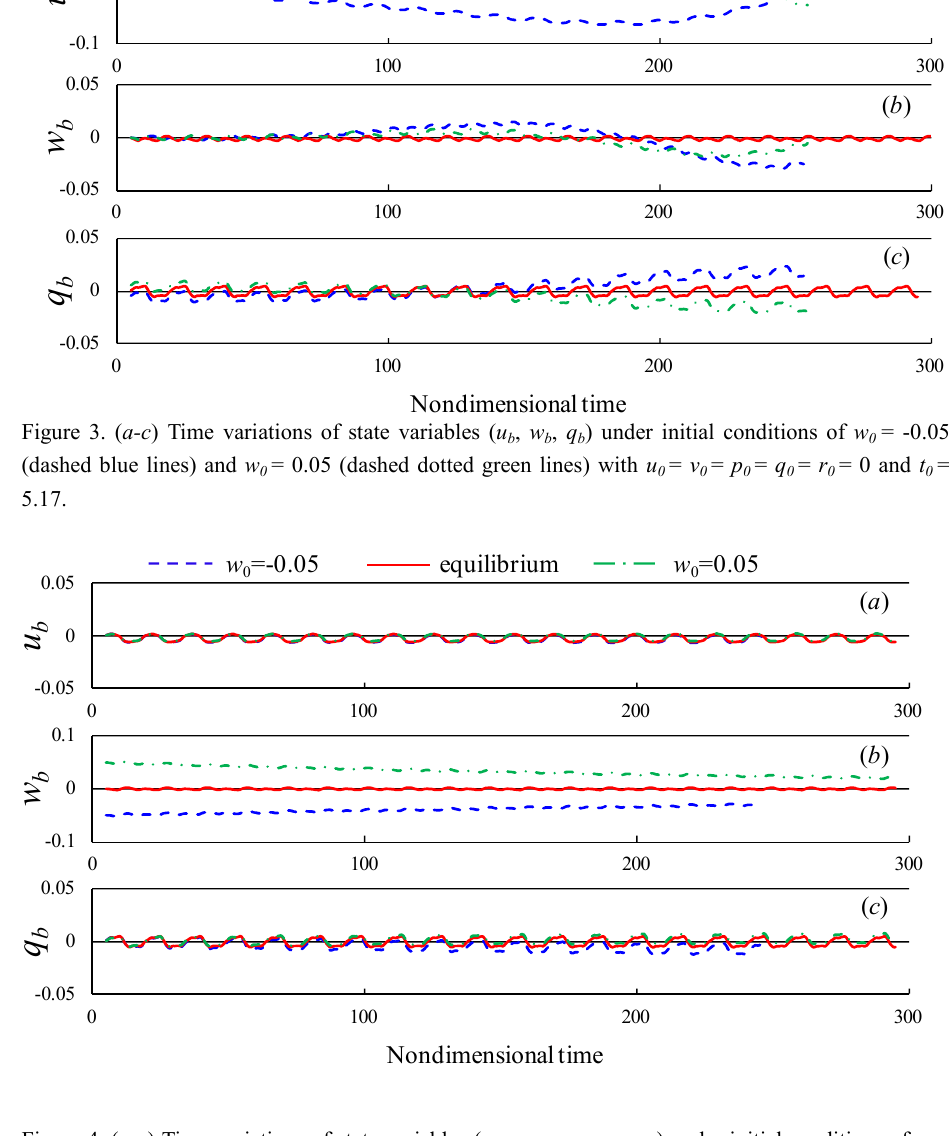
Figure 4. ( a-c ) Time variations of state variables ( u b , v b , w b , p b , q b , r b ) under initial conditions of q 0 = -0.005 (dashed blue lines) and q 0 = 0.005 (dashed dotted green lines) with u 0 = v 0 = w 0 = p 0 = r 0 = 0 and t 0 =